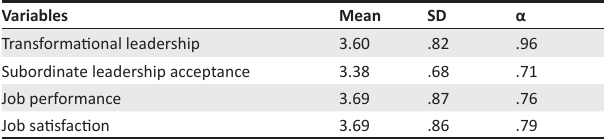
TABLE 1: Means, standard deviations and instrument reliabilities.